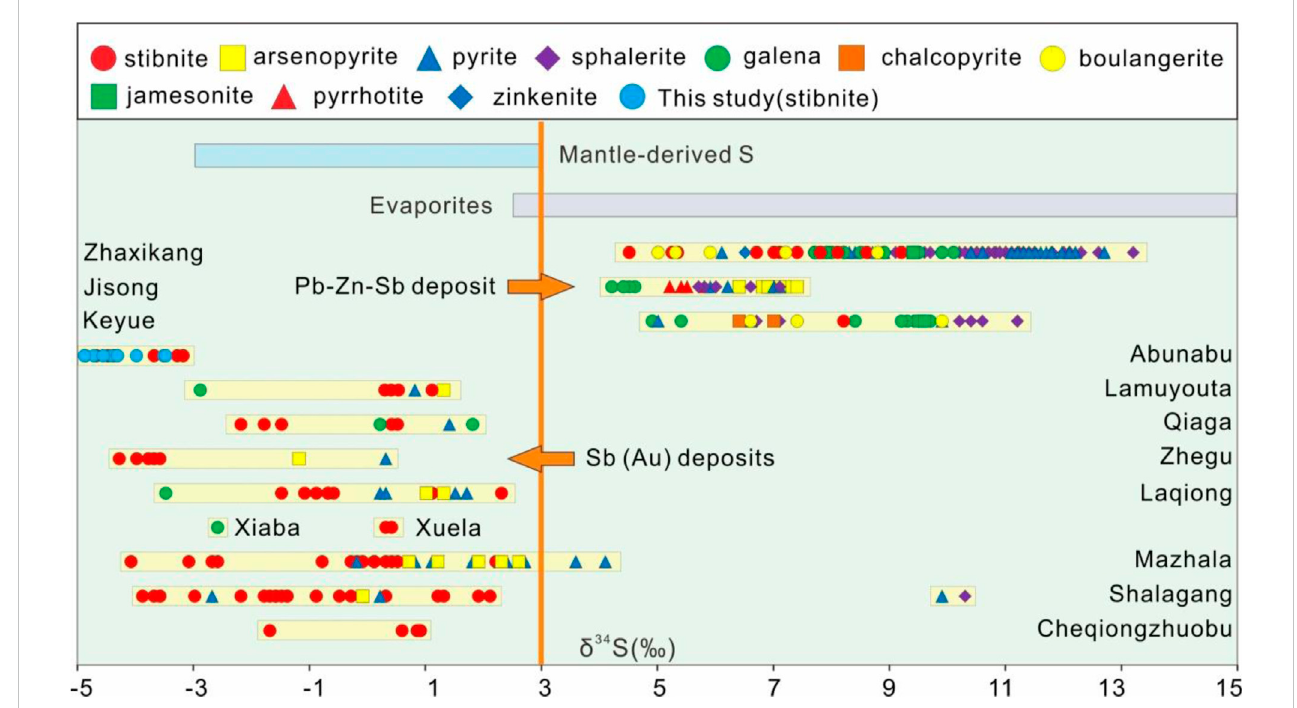
FIGURE 8 Sulphur isotopic composition of typical antimony polymetallic deposits in the Tethys Himalaya metallogenic belt [comparison of the S isotope composition derived from the mantle, and evaporates (Heyl et al., 1974; Zou et al., 2017; 2019; Cao et al., 2019)].